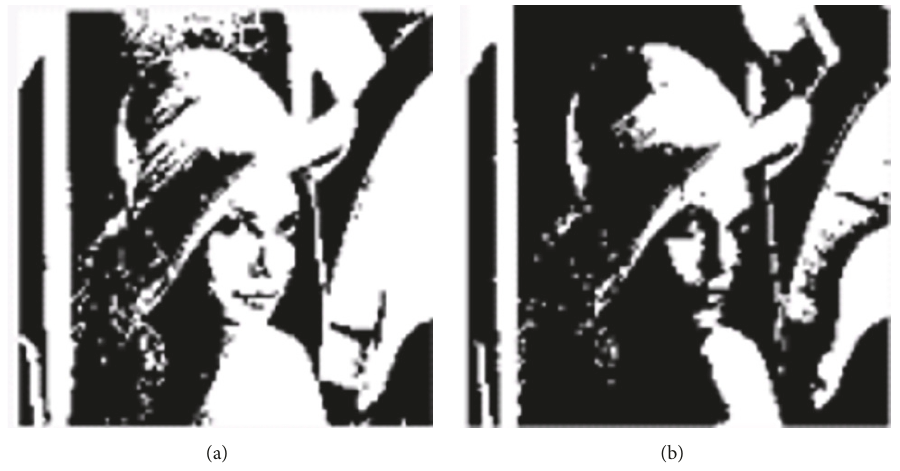
Figure 4: Threshold segmentation of image. (a) Binary image and (b) binary image with a range of